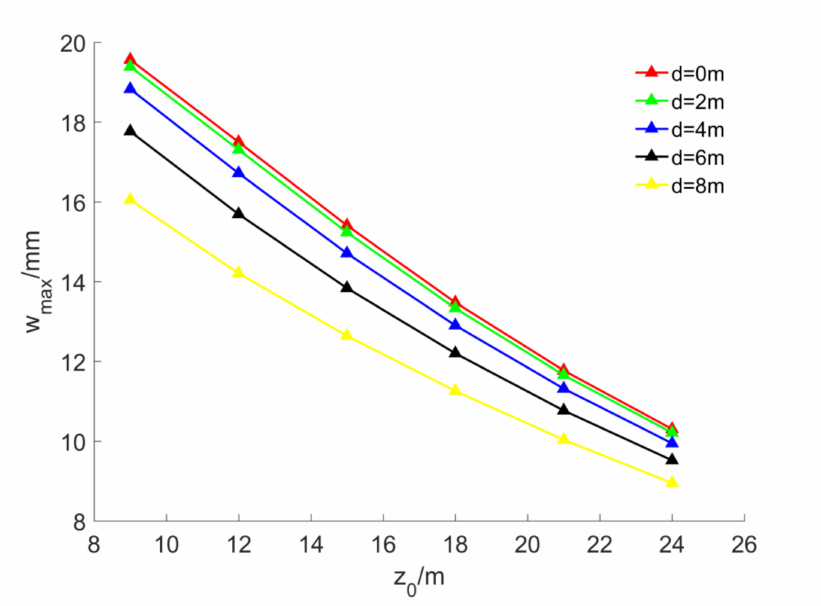
Figure 13. Influence of tunnel burial depth on the maximum longitudinal displacement of the existing tunnel.